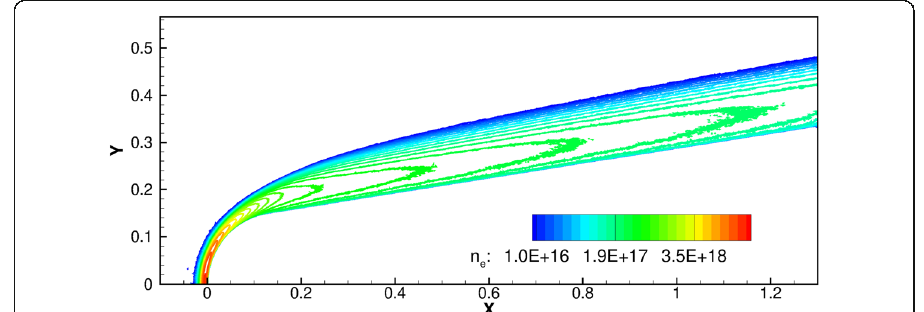
Fig. 1 Electron density. Logarithmic scale in the interval from 10 16 to 2.5·10 19 m −